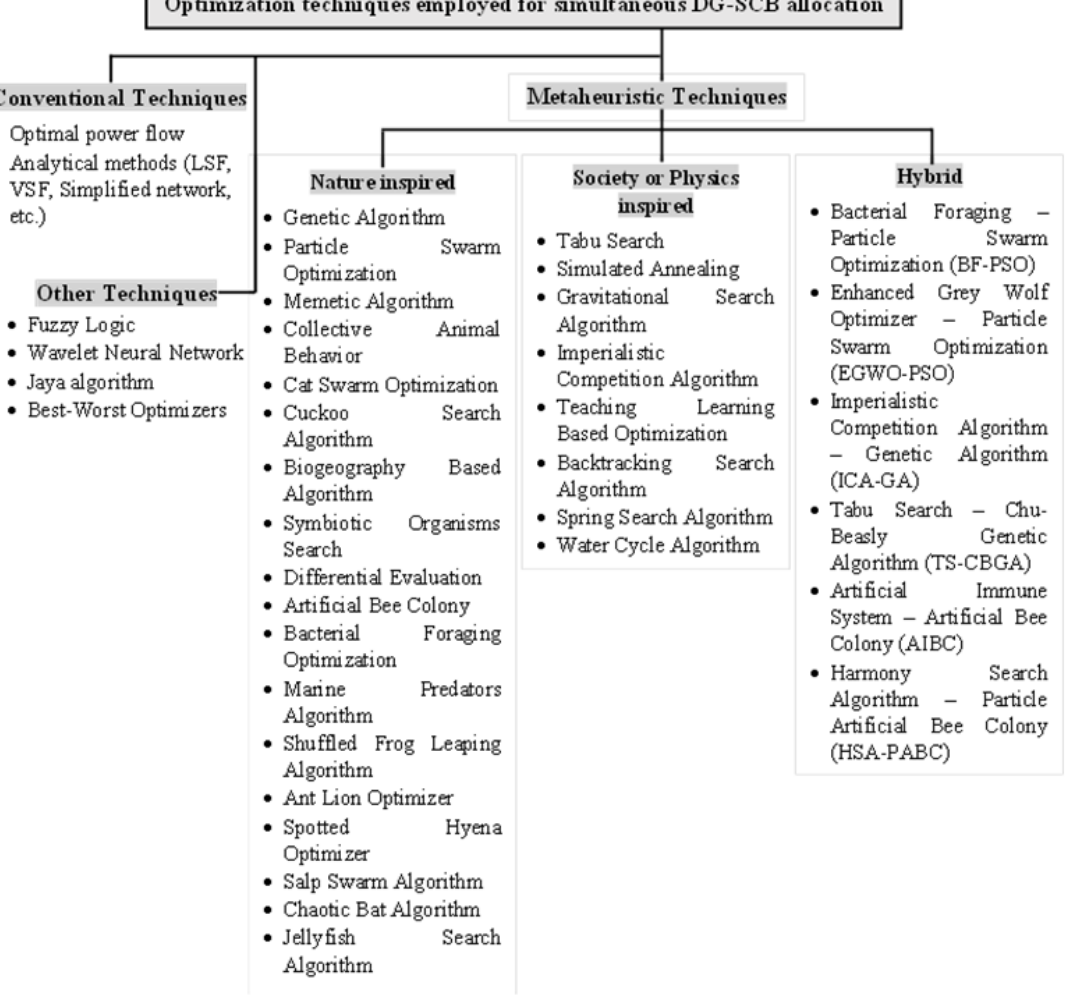
Figure 8. Classification of the optimization techniques employed for simultaneous DG-SCB alloca ‐ tion.